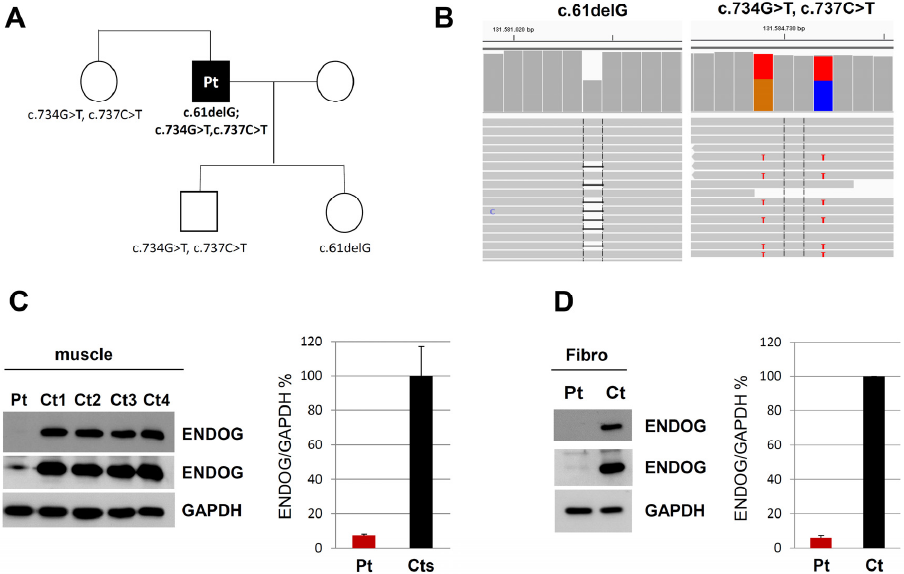
Figure 2. Genetic and protein studies on ENDOG. ( A ) Pedigree of the patient’s family, with segrega- tion analysis of the ENDOG variants. ( B ) Snapshots from IGV software (Version 2.3.72) of the ENDOG variants identified in the proband. The changes c.734G > T and c.737C > T were always present on the same reads, indicating they are on the same allele. ( C ) Western blot analysis of ENDOG in skeletal muscle lysates from control individuals (Ct) and the patient described in the manuscript (Pt). Two different exposure times were used for the ENDOG antibody (shorter exposure in the upper panel, longer exposure in the middle panel). GAPDH (lower panel) was used as a loading control, and for normalization of the ENDOG amount. Error bars indicate standard deviation. ( D ) Western blot analysis of ENDOG in fibroblasts from a control individual (Ct) and the patient (Pt). Two different exposure times were used for the ENDOG antibody (shorter exposure in the upper panel, longer exposure in the middle panel). GAPDH (lower panel) was used as a loading control, and for normalization of the ENDOG amount. Error bars indicate standard